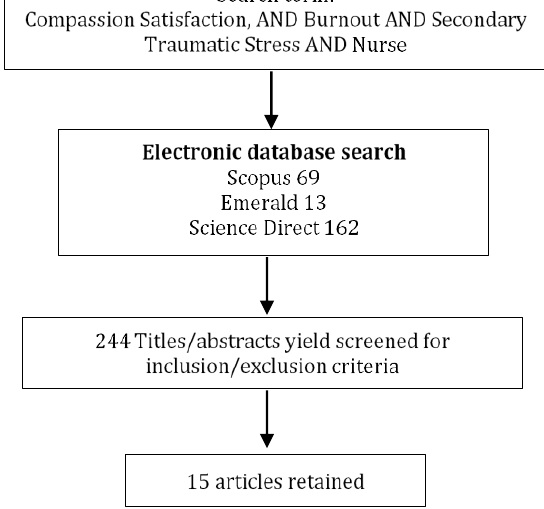
Figure 1: Literature search